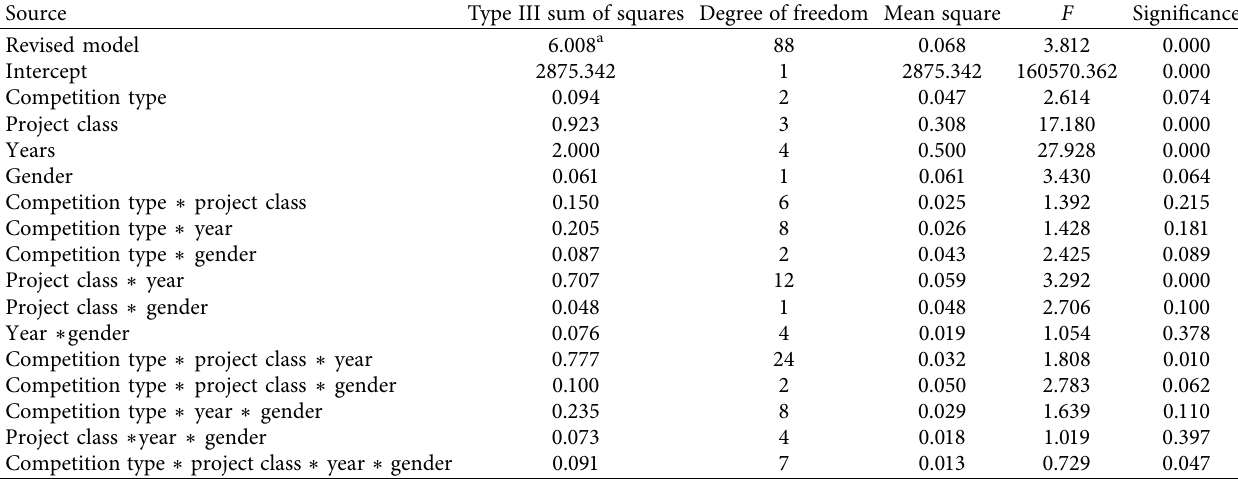
Table 5: Differences in the reaction time of the finalists in different rounds of competition.